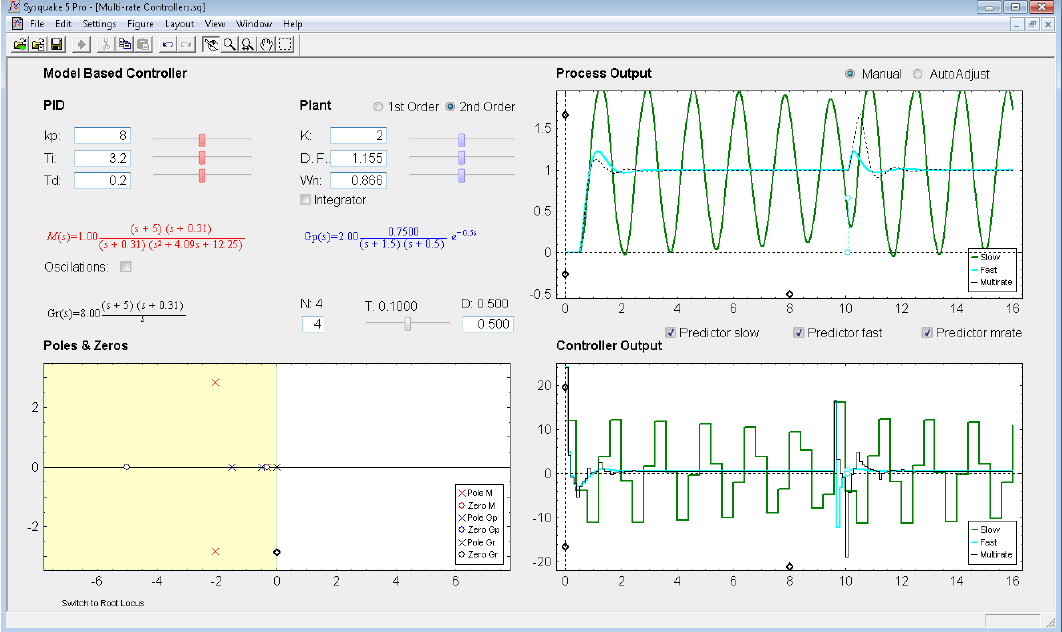
Figure 12. Application user interface for the Model-based (PID) controller with no